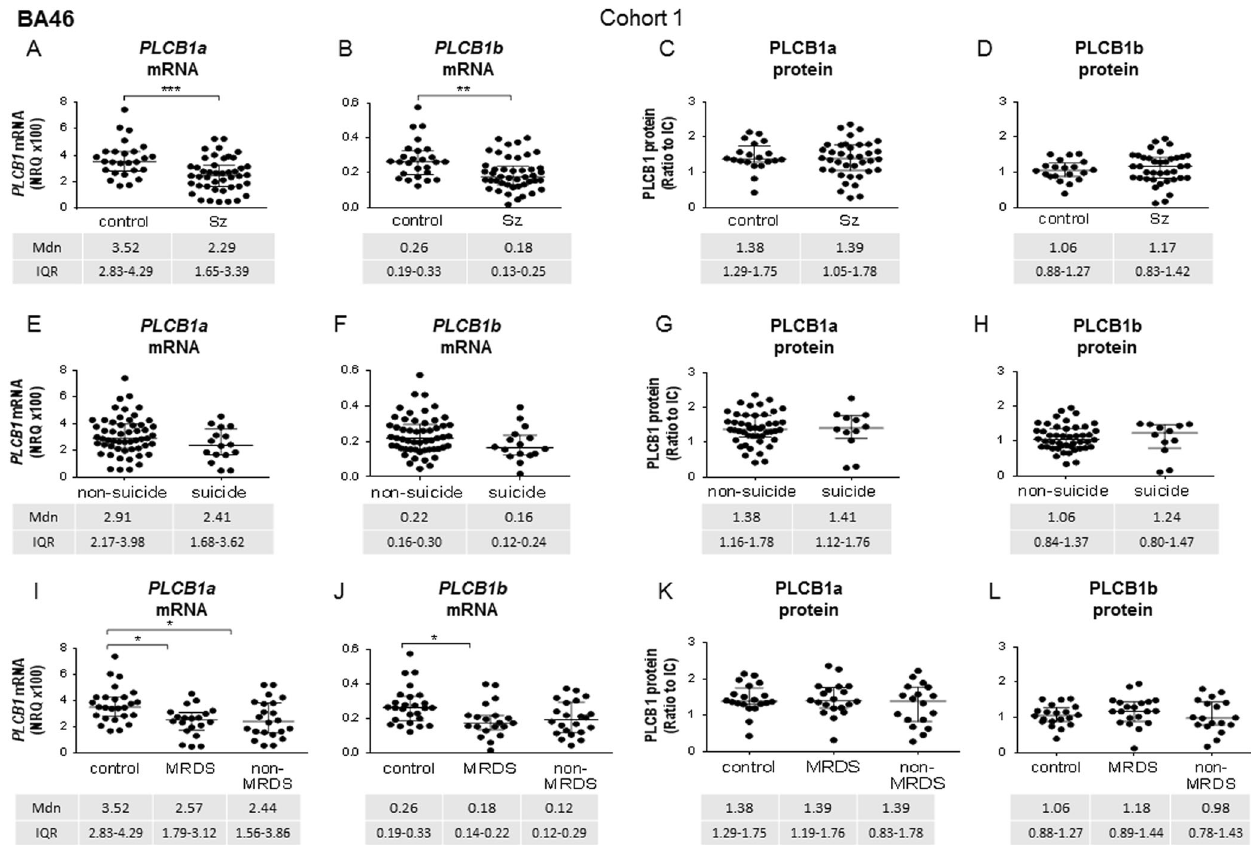
Fig. 1 PLCB1a and PLCB1b mRNA ( left ) and PLCB1a and PLCB1b protein ( right ) levels in cohort 1 measured in tissue from BA46, analysed as Sz vs. control ( a – d ), as suicide completers vs. non-suicide ( e – h ), and with Sz subjects divided into MRDS and non-MRDS compared to control ( i – l ). Error bars show median (Mdn) and